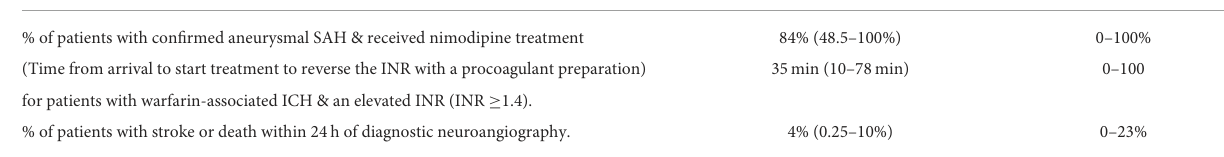
TABLE 4 Treatment options delivered for ICH/SAH. Variable Median (IQR) Minimum–Maximum % of patients with confirmed aneurysmal SAH & received nimodipine treatment 84% (48.5–100%) (Time from arrival to start treatment to reverse the INR with a procoagulant preparation) for patients with warfarin-associated ICH & an elevated INR (INR ≥ 1.4). % of patients with stroke or death within 24h of diagnostic